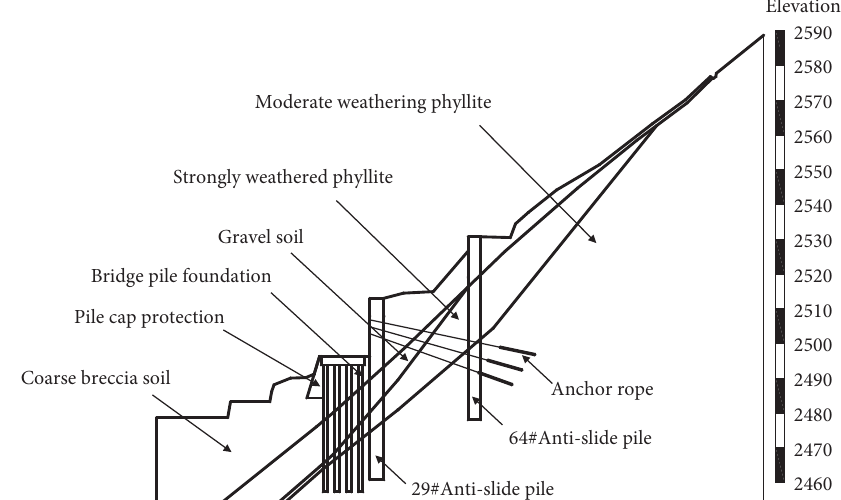
Figure 2: Engineering geological section of landslide.